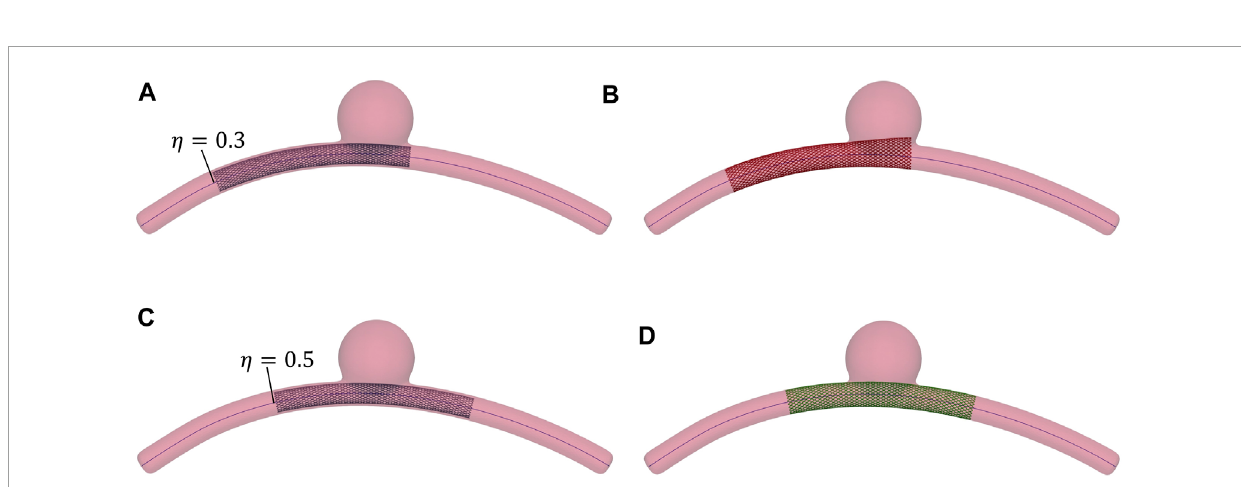
FIGURE 4 Examples of successful and unsuccessful deployment outcomes depending on the deployment site along the vessel centerline, η . The wire thickness is magnified ( 2 ×) to better visualise the stent. (A) Stent positioned at η = 0 . 3. (B) Unsuccessful deployment: landing zone inside the aneurysm space. (C) Stent positioned at η = 0 . 5. (D) Successful deployment: good conformity between stent and vessel